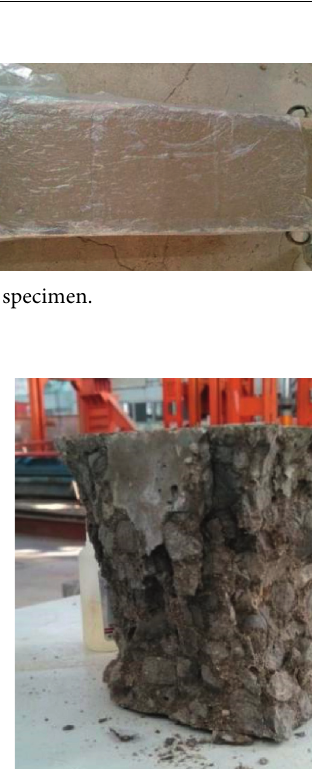
Figure 3: A picture after the specimen is